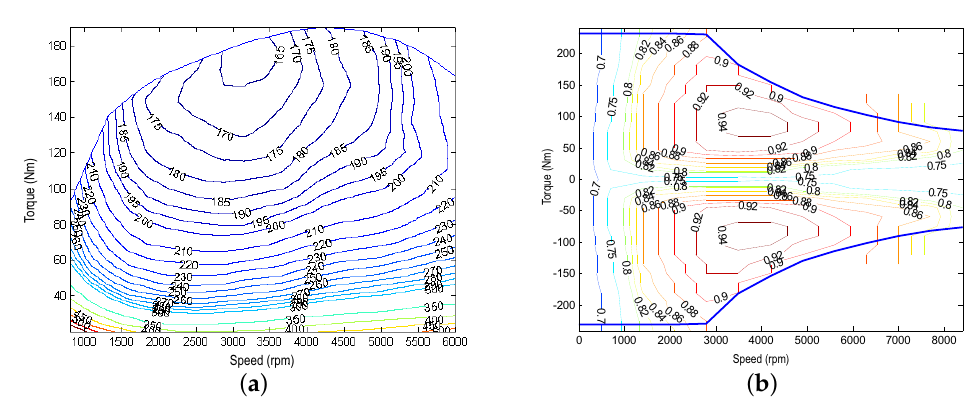
Figure 14. Power system map of extended-range electric vehicle (E-REV). ( a ) The external characteristic curve and brake specific fuel consumption (BSFC) map of the engine. ( b ) The maximum torque curve and efficiency map of the